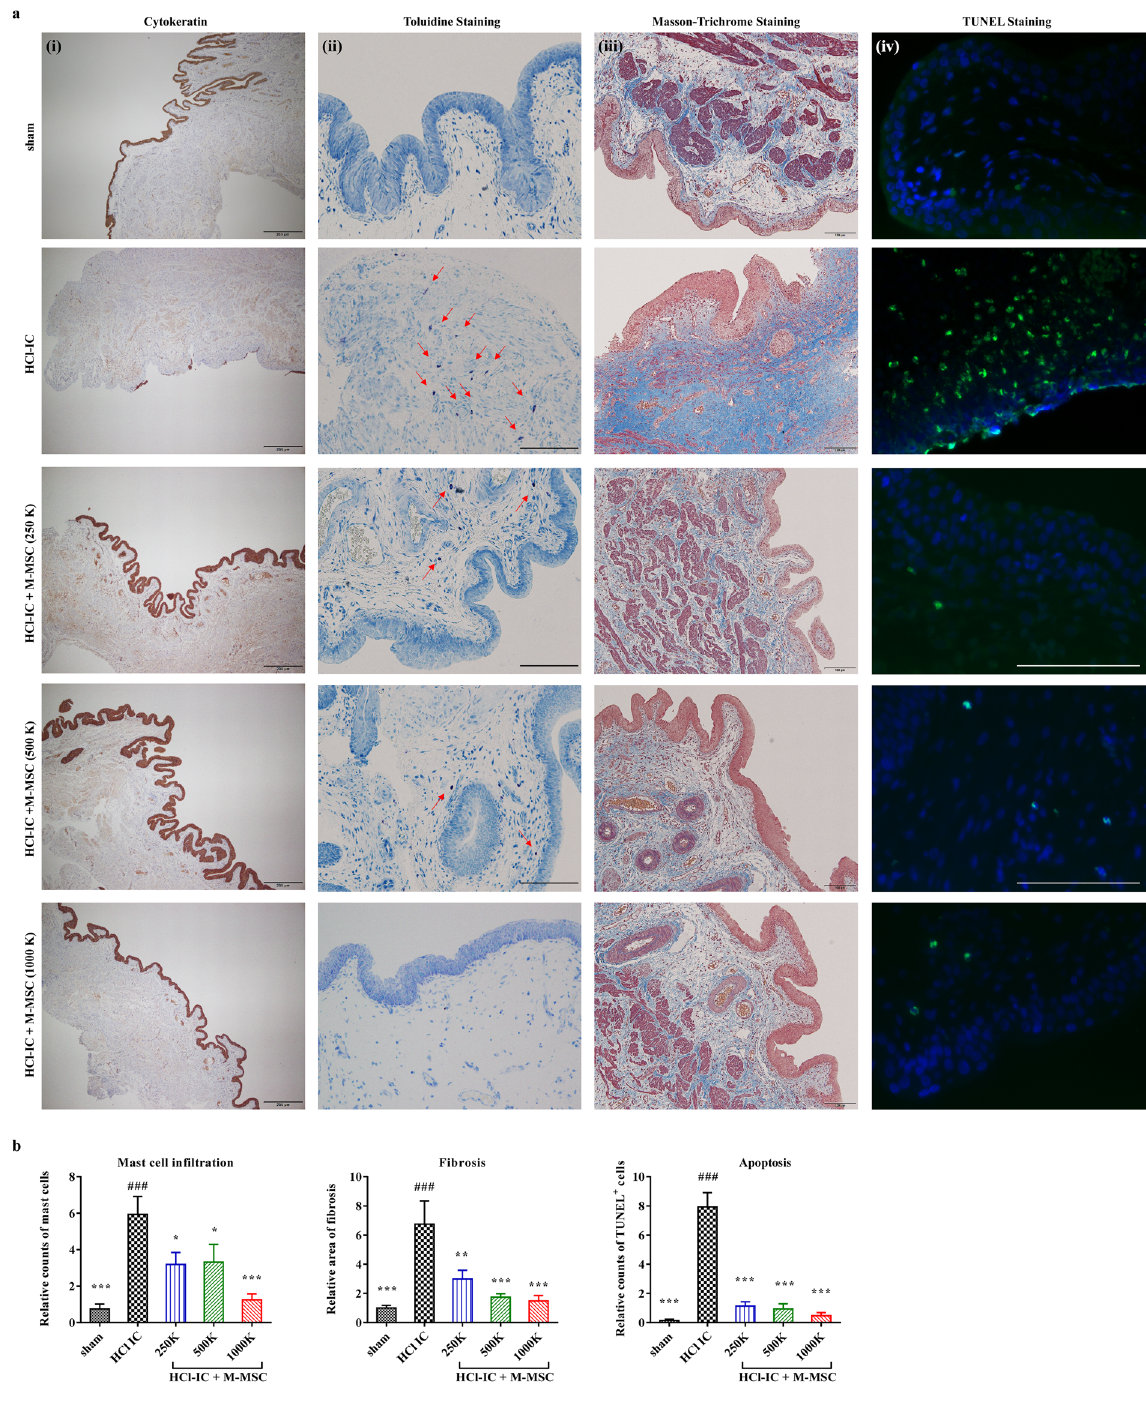
Figure 3. Histological analysis of M-MSC injection effects on HCl-induced bladder injury. ( a ) The immunostaining of cytokeratin (i) (magnification × 40, scale bar = 100 μ m), Toluidine blue (ii) (magnification × 200, scale bar = 100 μ m), Masson’s trichrome staining (iii) (magnification × 100, scale bar = 100 μ m), and TUNEL assay (iv) (magnification × 400, scale bar = 100 μ m) in bladder tissues of HCl-IC rats 1 week after injection of PBS vehicle or M-MSCs at the indicated dosage (K = a thousand). Arrows indicate infiltrated mast cells. Sham: sham-operated. Nuclei were stained with Mayer’s hematoxylin (i, ii, and iii) or DAPI (blue, iv). Arrows (ii) indicate infilated mast cells. ( b ) Quantification of histological examniations. Data were normalized to the sham group (n = 15). Data are presented as the mean ± SEM, * p < 0.05, ** p < 0.01, *** p < 0.001 compared to the HCl-IC group; # p < 0.05, ## p < 0.001, ### p < 0.001 compared to the 1000 K group with Bonferroni